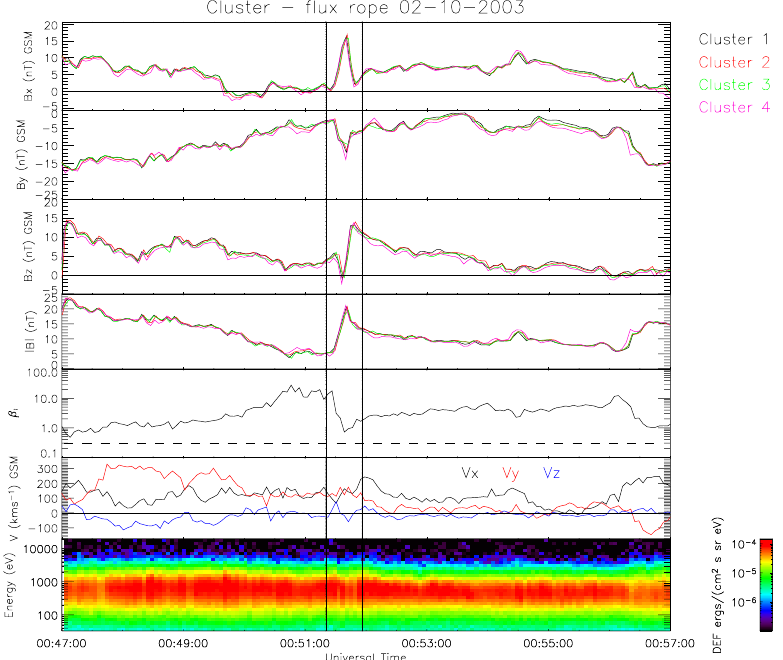
Fig. 3. Cluster observations of 2 October 2003. Panels 1 to 4 show components of B and | B | from each spacecraft (Cluster 1 – black, Cluster 2 – red, Cluster 3 – green, Cluster 4 – magenta). Panel 5 shows plasma β i , derived from Cluster 1 ion moments. β i =0.3 is marked, a value of β i above this is indicative of plasma sheet conditions. Panel 6 shows velocities from CIS (Cluster 1, V x black, V y red, V z blue). Panel 7 contains a spectrogram of the direction-averaged differential energy flux for electrons in the energy range 30eV–30KeV recorded by the PEACE instrument on Cluster 4. The flux rope event is marked between two black